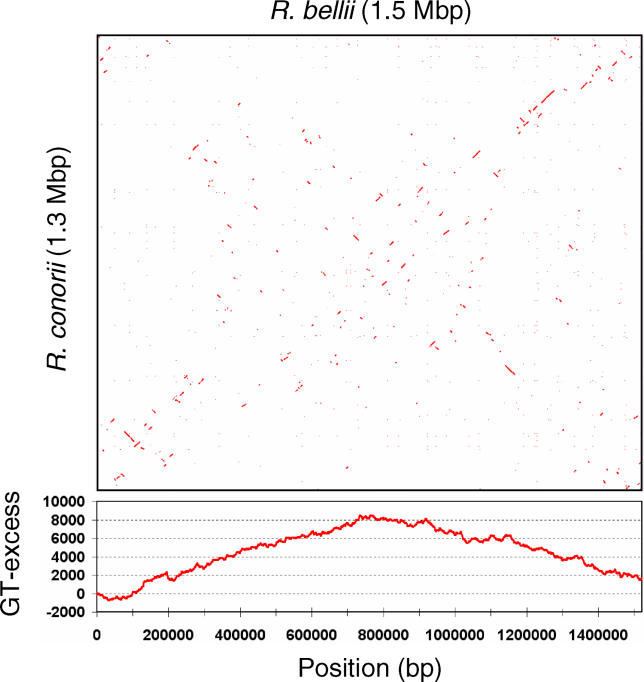
Comparison of R. bellii and R. conorii Genomes, and the Cumulative Nucleotide-Excess Curve for the R. bellii GenomeIn the top panel, dots represent homologous genomic segments detected by BLASTN (E-value < 0.001). Bottom panel shows the GT-excess plot.